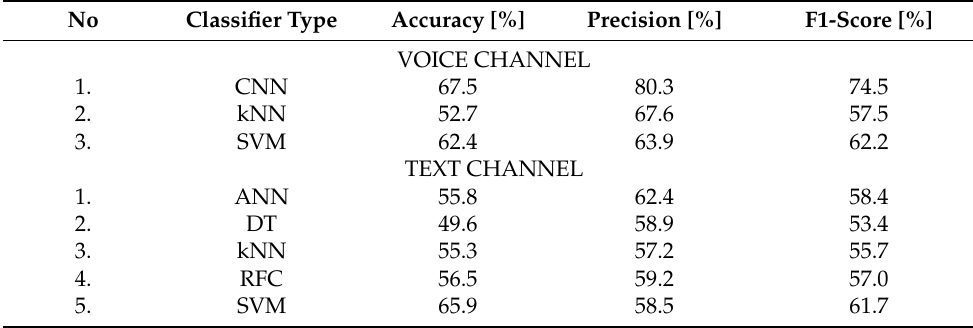
Table 6. Results of verification of the machine emotion detection